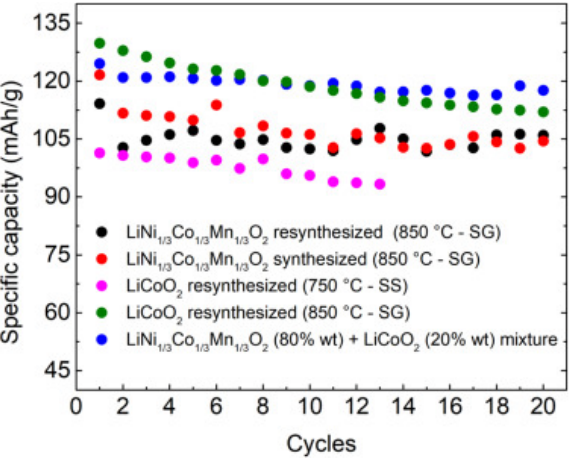
Figure 7. Cycling performance for electrodes of LCO, NCM111, and their mixture. The compounds were obtained from resynthesis and synthesis by sol–gel (SG) and solid-state reaction (SS). Used with permission of Elsevier Science & Technology Journals, from Ref. [62]; permission conveyed through Copyright Clearance Center, Inc..